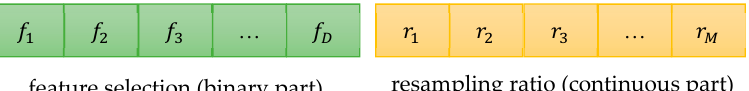
Figure 1. The particle position code in MPSO.